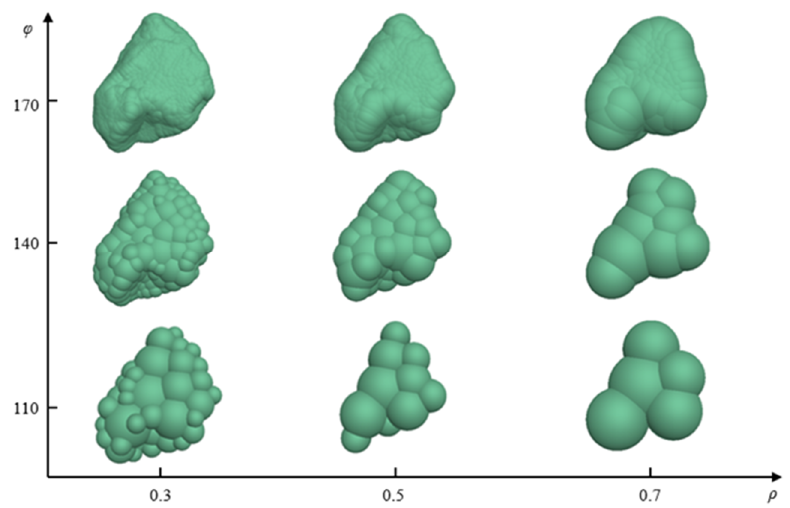
Figure 1. Clumps created using different sphere size ratios ( ρ ) and interaction angles ( ϕ ).